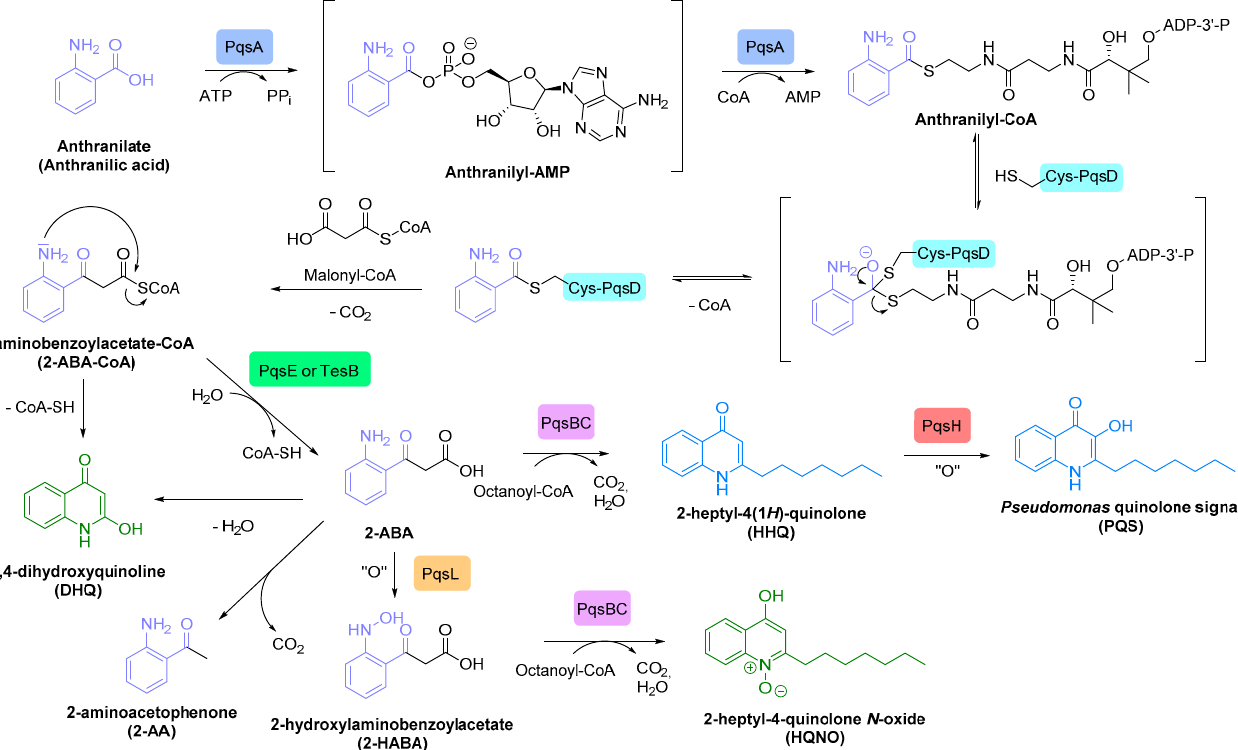
Scheme 3. AIs of pqs system: the 2-heptyl-3-hydroxy-4(1 H )-quinolone (PQS) and the 2-heptyl-4(1 H )- quinolone